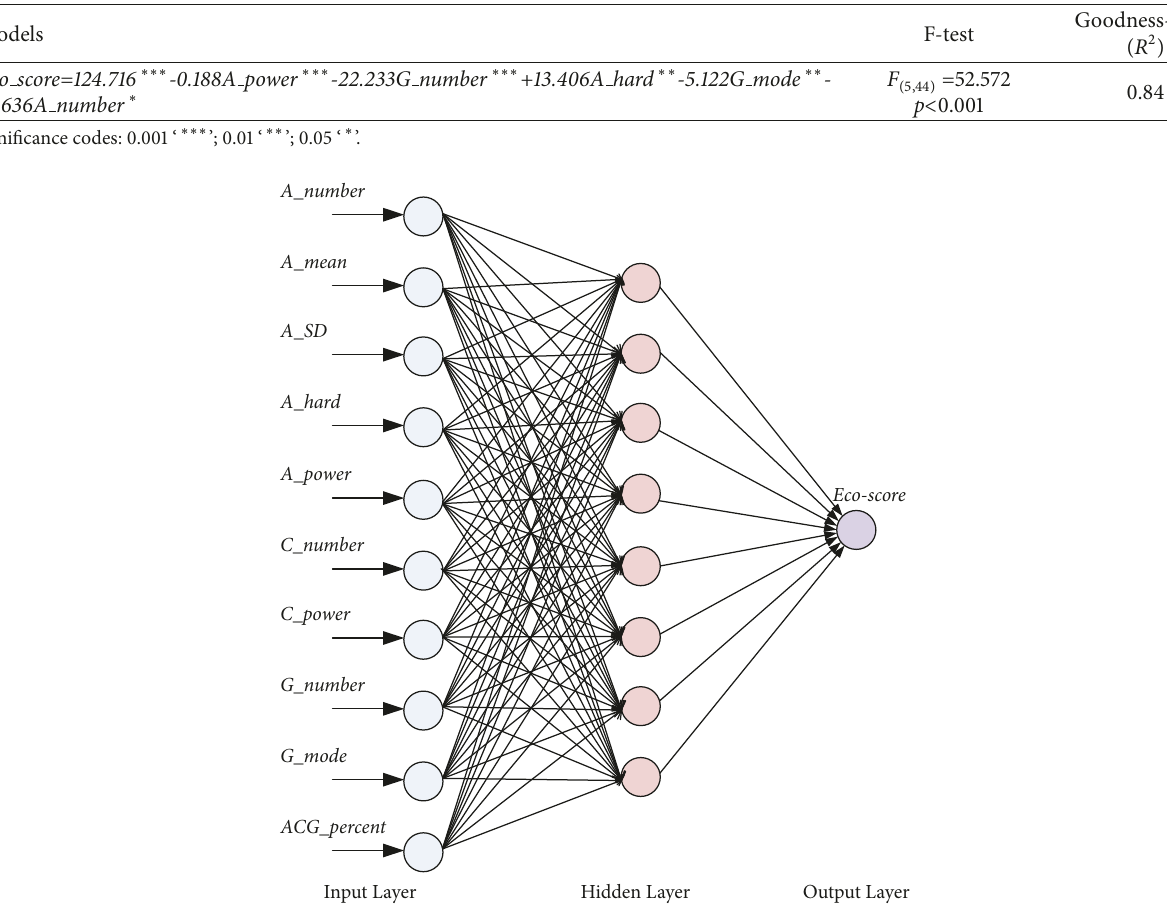
Figure 6: BP neural network structure for ecoscore estimation of driver performance.